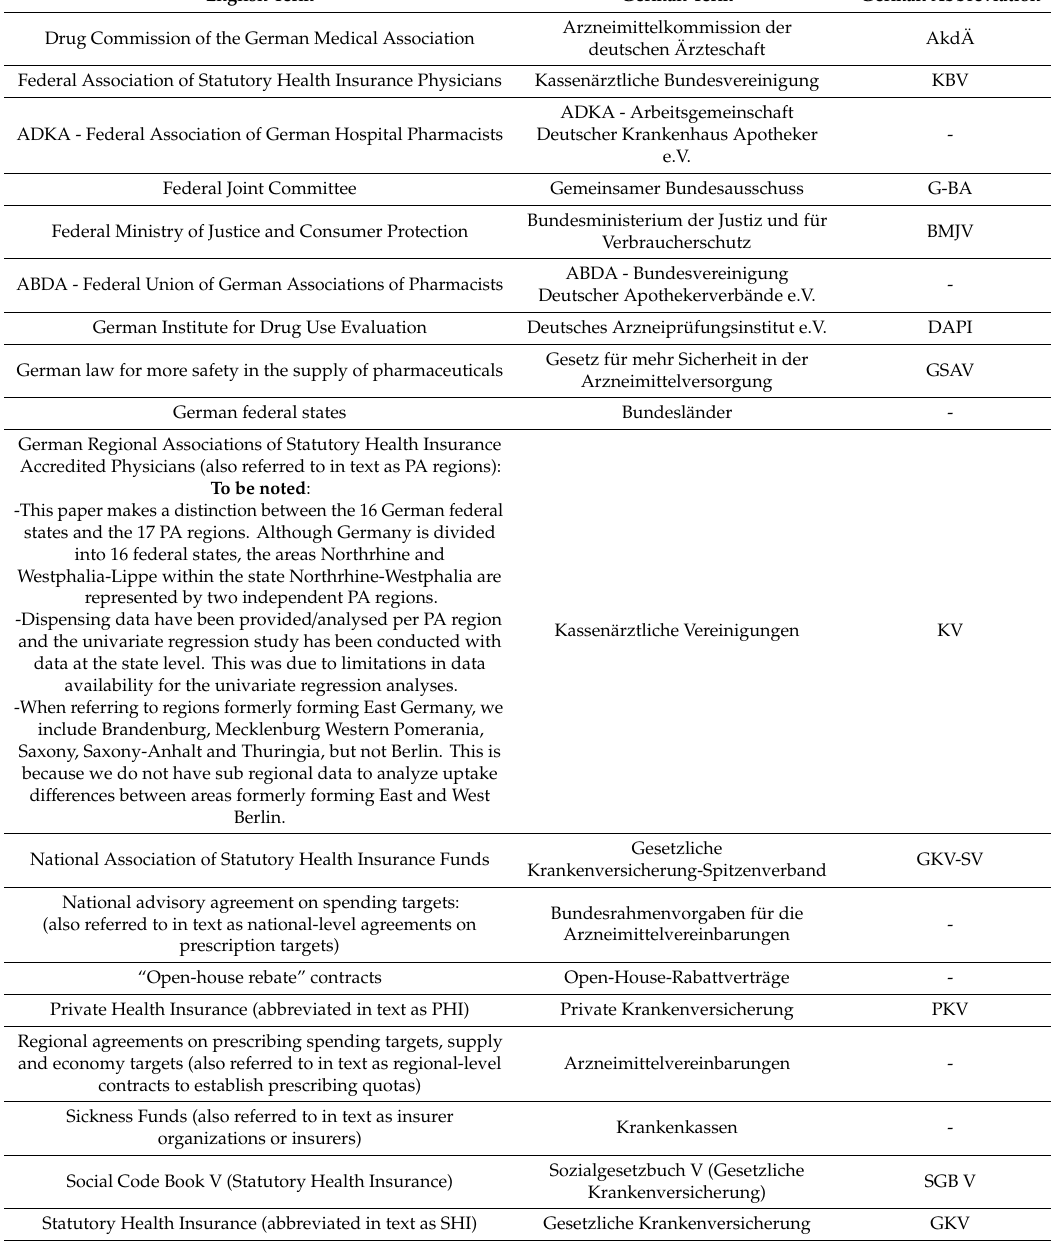
Table 4. Glossary of English / German terms and